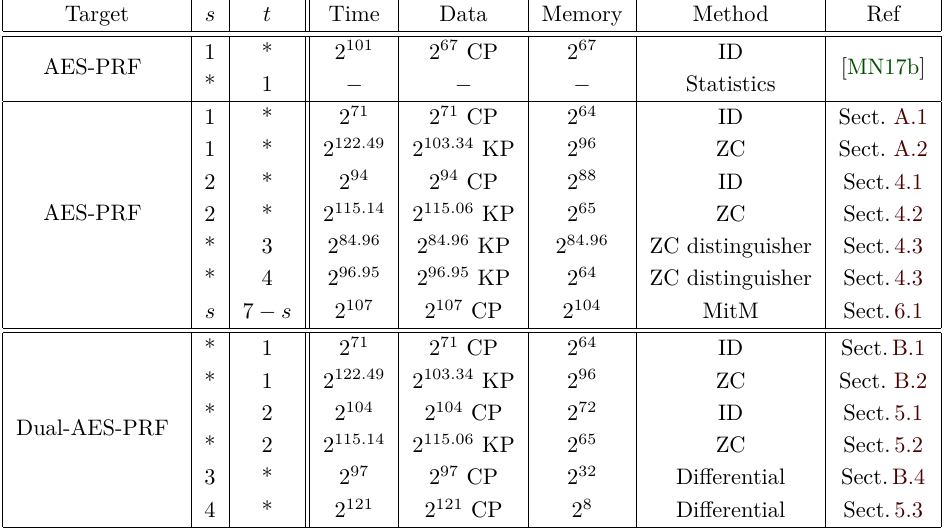
Table 1: Summary of results. The mark * in column s is 10 − t and that in column t is 10 − s , but they can take any value.